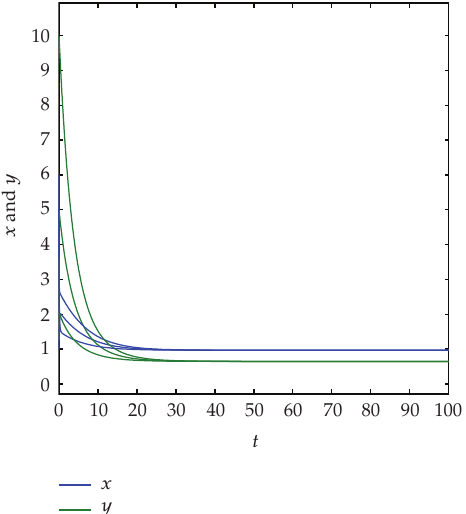
Figure 3: Solution curves of system (cid:6) 1.1 (cid:7) with the parameters given by Example 6.1 when r 1 (cid:8) 1.